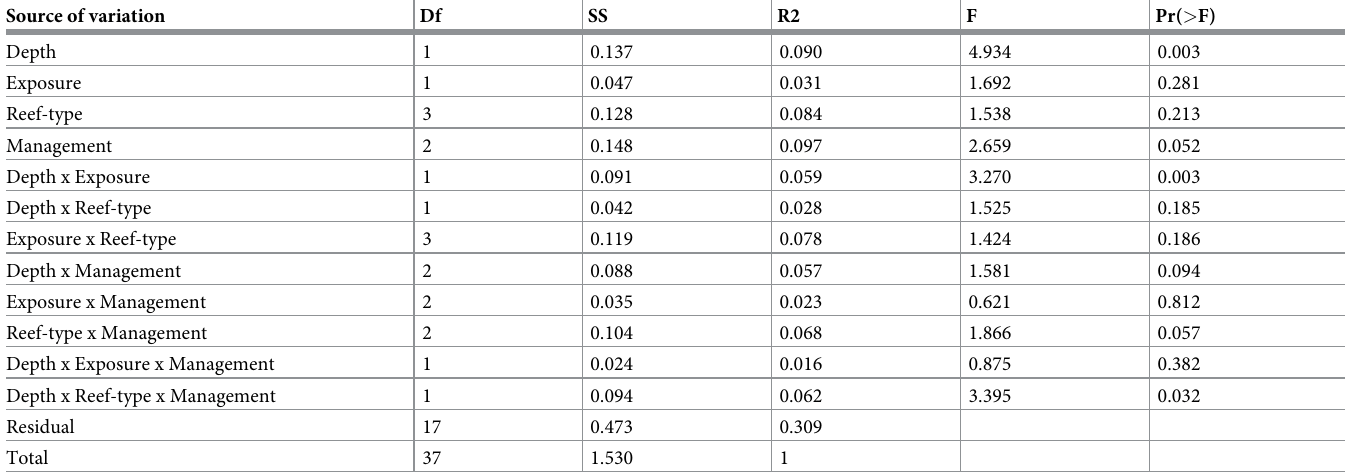
Table 3. PERMANOVA test on the effect habitat factors and management contributing to the differences in benthic communities.